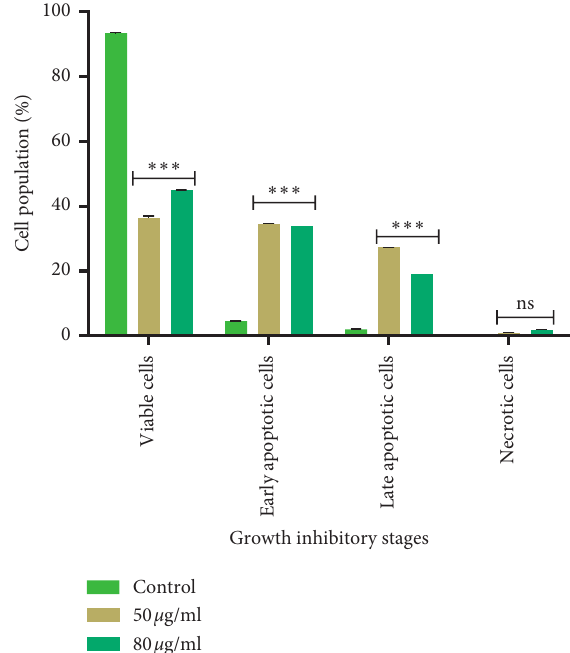
Figure 4: Apoptotic effect of N97 against HeLa cells. The pro- portions of Annexin V+/PI − and Annexin V+/PI+cells indicating the percentage of viable cells, early and late stages of apoptosis, and necrosis. A two-tailed, unpaired t -test was used to analyse sig- nificance. ∗ p < 0 . 05, ∗∗ p < 0 . 001, ∗∗∗ p < 0 . 0001, significant differ- ence compared to the untreated